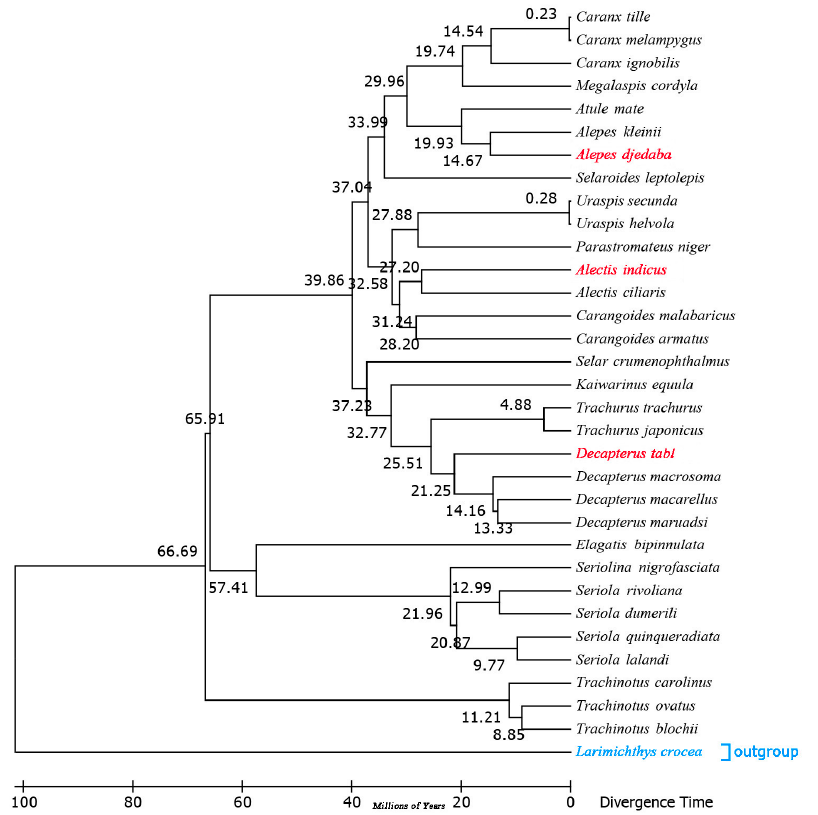
Figure 8. Chronogram for the 32 species of Carangidae with a single outgroup Larimichthys crocea based on the Bayesian topology calculated from analysis of the 13 PCGs. Divergence times were estimated using three calibrations. The red fonts represent the three species sequenced in this study, and the blue fonts represent the outgroup species.